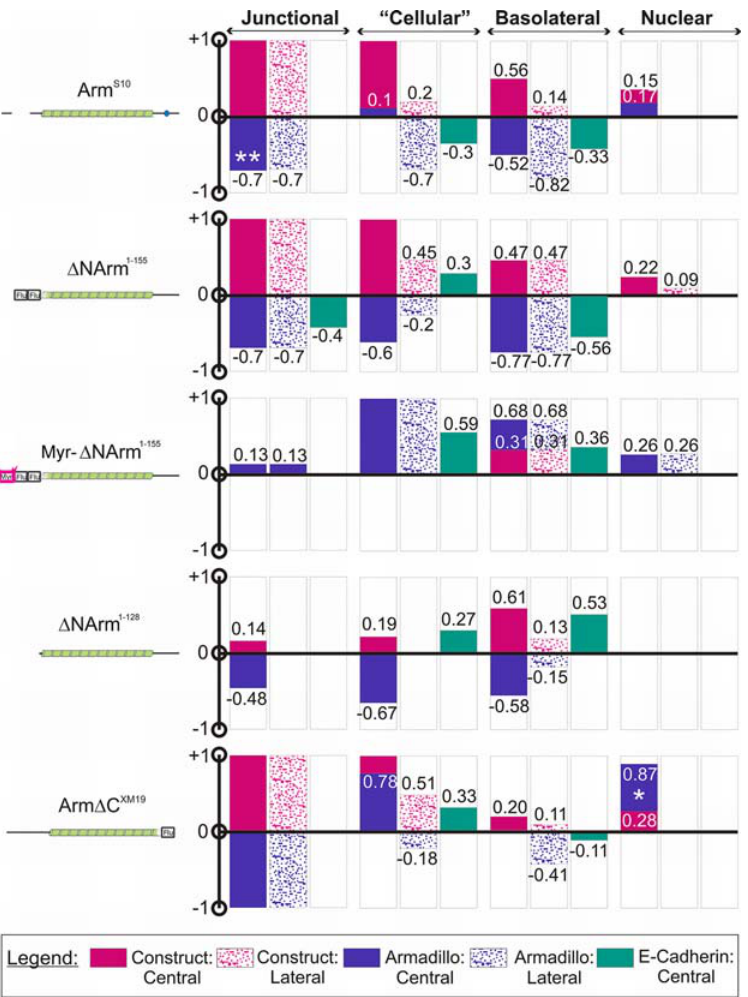
Figure 12. Summary of quantification of changes in levels upon Armadillo mutant overexpression. Levels of endogenous Armadillo (blue), overexpressed mutant (pink) and E-Cadherin (green) were assessed in (adherens) junctional, ‘‘cellular’’, basolateral (membrane) and nuclear compartments. The ‘‘cellular’’ compartment assesses levels across a field of cells encompassing the basolateral membrane, nucleus and cytoplasm. Mutant constructs that were assessed are illustrated to the left of the graphs, and included Arm S10 , D NArm 1–128 , D NArm 1–155 , Myr- D NArm 1–155 and Arm D C XM19 . + 1 and 2 1 represent maximal proportion changes in levels above and below the wild type baseline value of 0. Empty boxes indicate no change from wild type. dppGAL4 driver levels are lower in ‘‘lateral’’ relative to ‘‘central’’ domains of expression, as reflected by spotted versus solid colours. E-Cadherin levels were not assessed in the nuclear compartment (N/A). doi:10.1371/journal.pone.0002893.g012 Figure 12). These data perhaps indicate that, unless Armadillo can